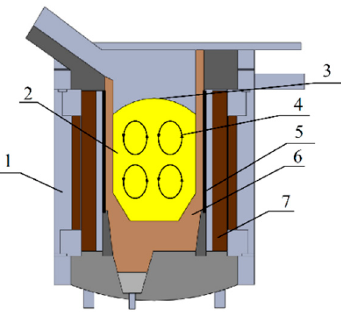
Figure 1. Scheme of the induction crucible furnace: 1—steel construction; 2—liquid metal; 3—meniscus; 4—mixing of metal; 5—inductor; 6—crucible; 7—ferromagnetic core [1].